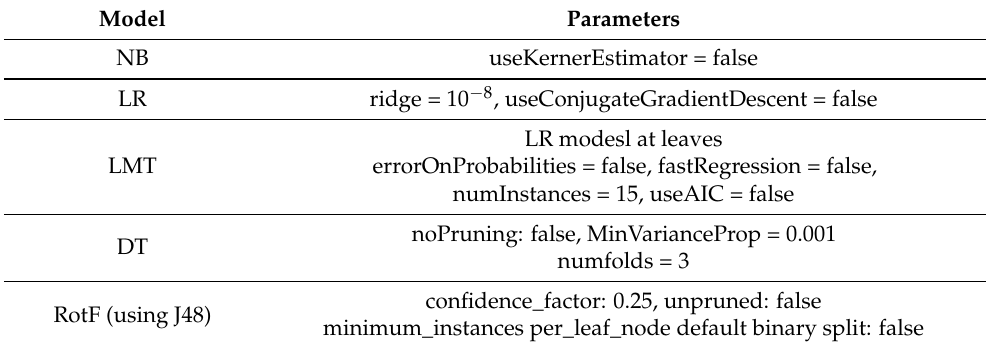
Table 3. Machine Learning Models’